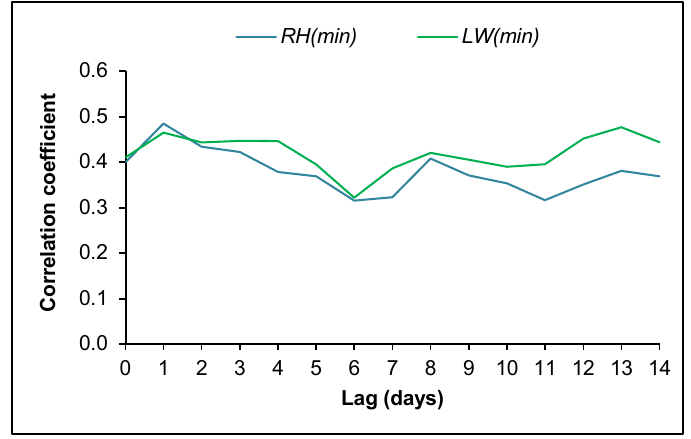
Figure 5. Correlation (R) of leaf wetness (LW) and air relative humidity (RH) with H. fraxineus air inoculum lag (days).